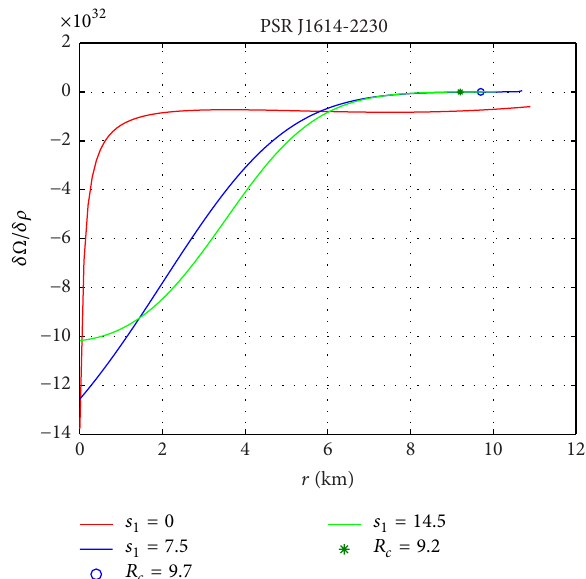
Figure 8: Stability regions for 𝛾 = 0.200 , 𝛼 = 0.04 , and 𝑠 1 = 0, 7.5, 14.5